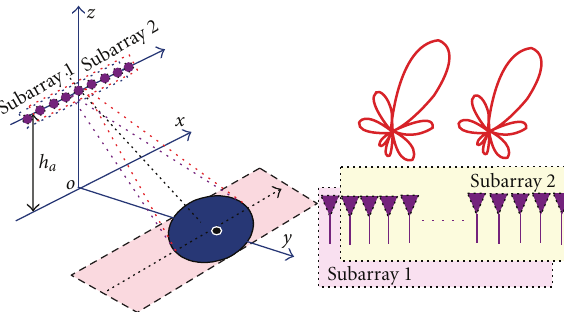
Figure 1: Illustration of the flexible phased-MIMO antenna